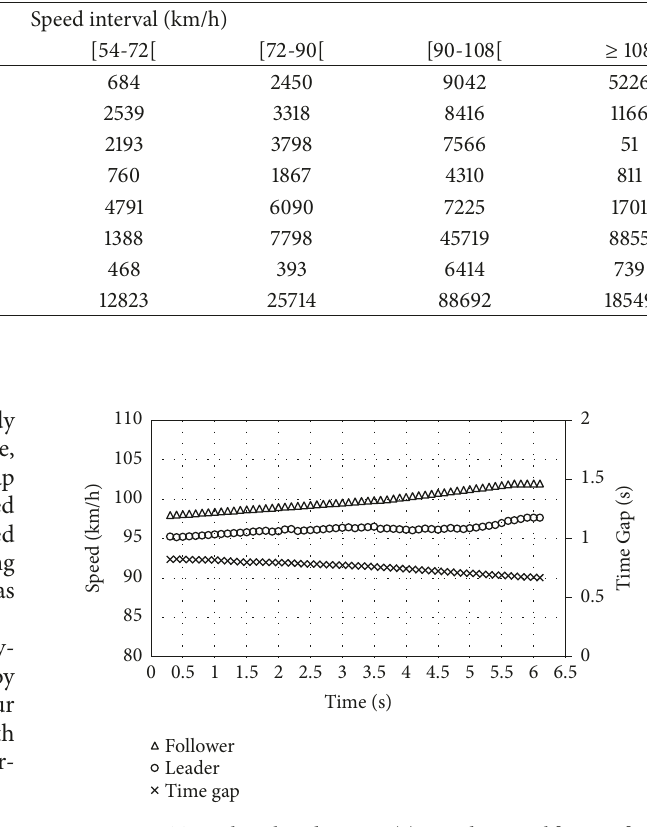
statistics as well as the best statistical distributions fitting the dataset for each driver. The data were then analyzed per speed interval grouping all the drivers. This was done in spite of the fact that the number of samples per speed interval differed from one driver to another. For example, in the speed interval [90, 108[ more than 50% of the total data belongs to Driver 363 and therefore their behavior would have had the greatest effect on the results for this speed